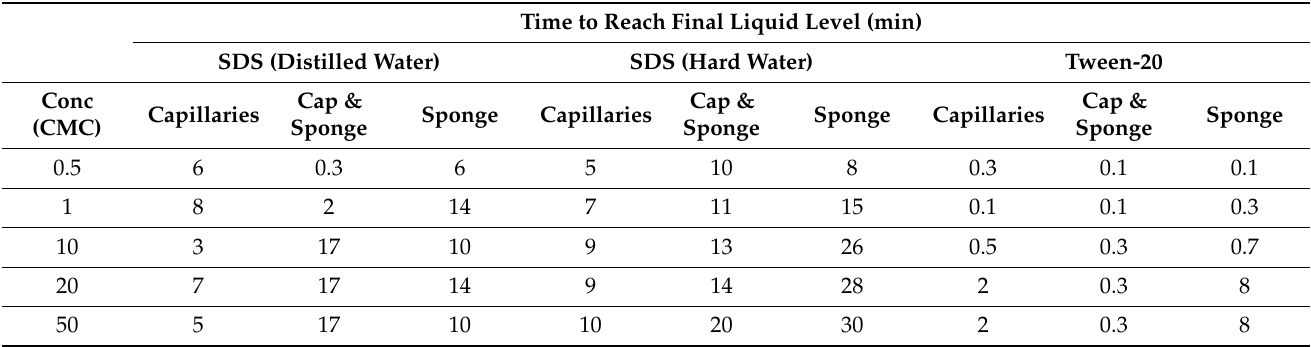
Figure 8. Rate of foam drainage on capillaries (cap), capillaries, and dishwasher sponge system and foam formed by dishwasher sponge. ( a ) SDS solutions with hard water at all five concentrations and ( b ) Tween-20 solutions at 0.5 and 50 CMC. Table 3. Time surpassed for the initial liquid level to be reached for each experimental